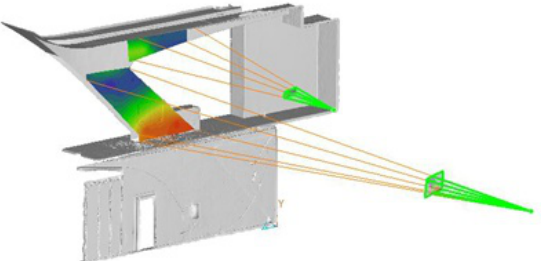
Figure 14 . Projection of the corrosion potential map of the P12 pillar on the reality-based model (3D mesh).